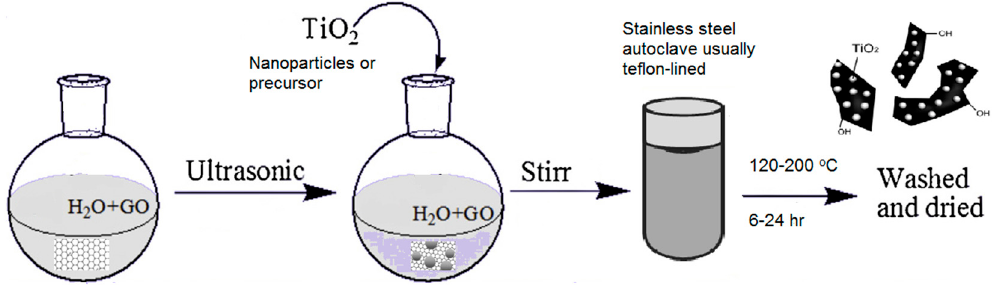
Figure 5. Schematic diagram of the HT synthesis of TiO 2 /G nanocomposites, adapted with permission from reference [90]. Copyright 2014 Elsevier.